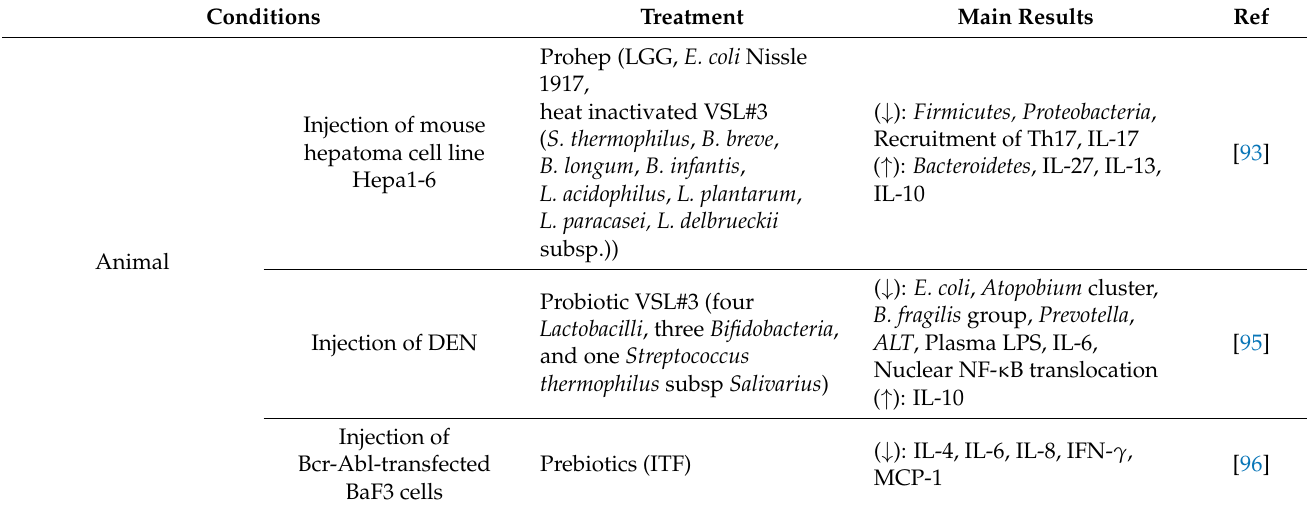
Table 4. Animal and human studies using diet in